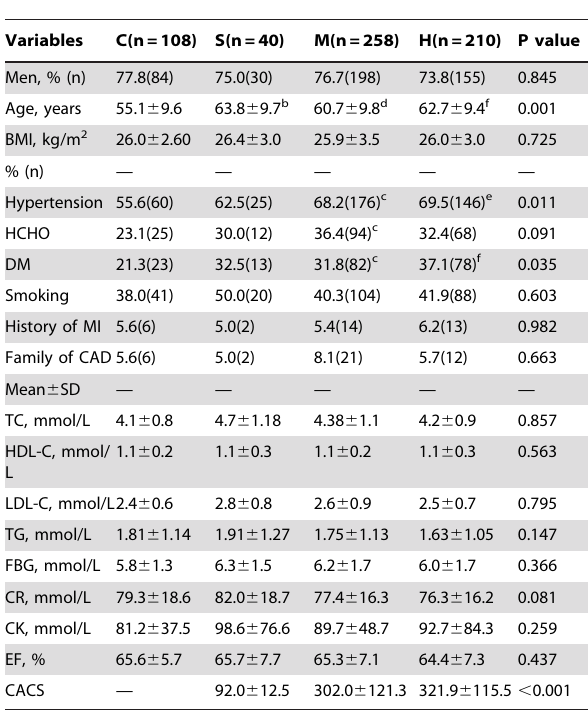
ST failure, stent delivery failure; SNC, stented non-calcified plaque; SSC, stented spotty calcified plaque; SMC, stented medium calcified plaque; SHC, stented heavy calcified plaque; PP, pressure of balloon pre-dilation; DP, diameter of pre- dilation balloon; BDT, time of balloon dilated. a indicates a significant difference of p , 0.05 between the S group and the C group and b p , 0.01 between the two groups. c indicates a significant difference of p , 0.05 between the M group and the C group and d p , 0.01 between the two groups. e indicates a significant difference of p , 0.05 between the H and the C group and f p , 0.01 between the two